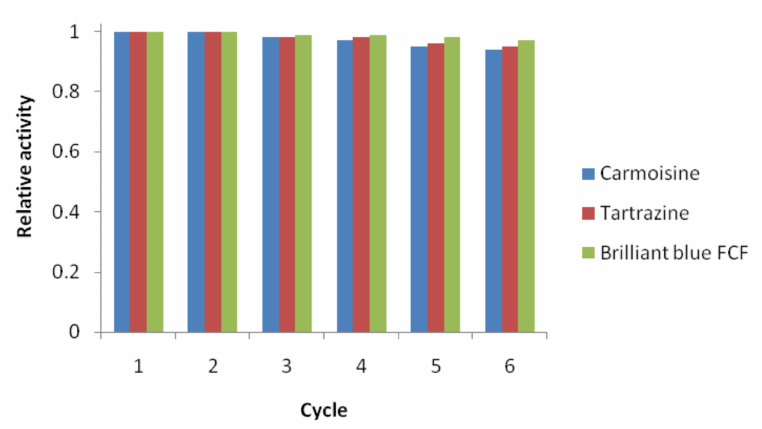
Figure 10. Reusability of silver nanoparticles for the reduction of organic dyes with NaBH